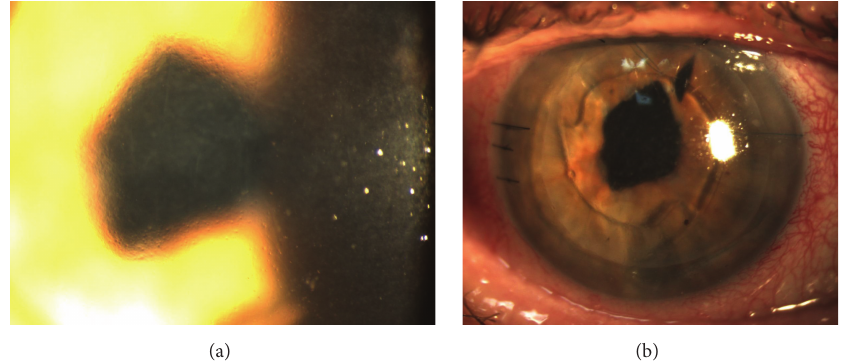
Figure 3: (a) Preoperative photo (above) demonstrating corneal edema. (b) Postoperative photos with ACIOL, clear cornea, and stable DSEK graft with corneal stay